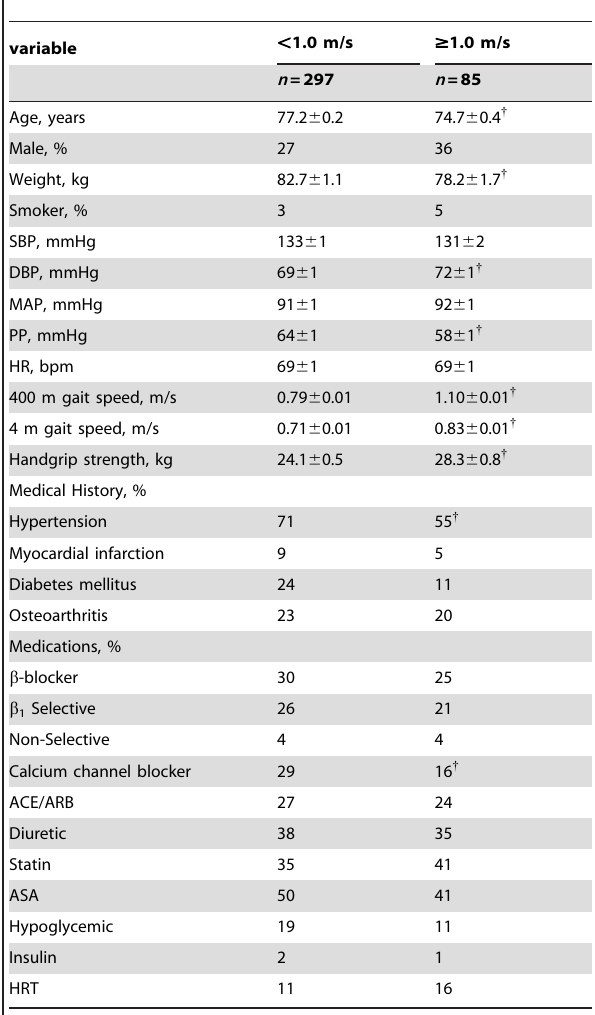
Table 2. Participant characteristics according to slow gait speed (defined as , 1.0 m/s).